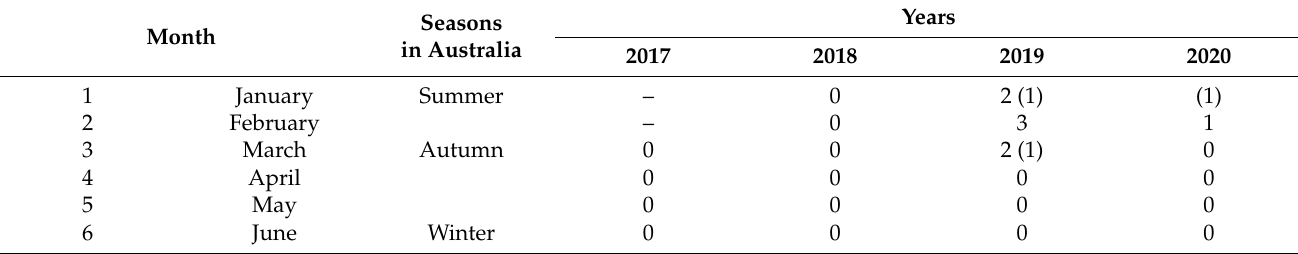
Table 3. The number of ISS LIS flashes, which, according to MCD14ML wildfires, are probably sources of wildfires. The values in brackets are related to events which did not complete the requirements for selection, specified in Section 2.5. For example, single wildfire hotspots were present in the 3 h prior to the ISS spacecraft